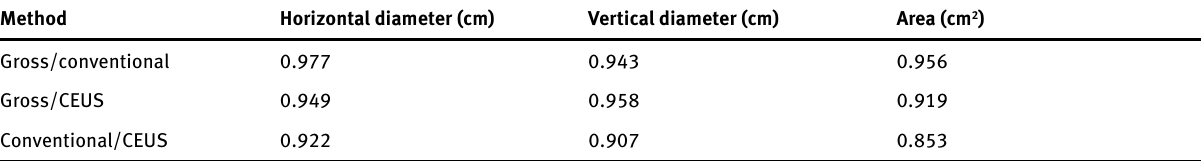
Table 3 . Pearson correlation analyses of the ablation lesion areas as measured by the three